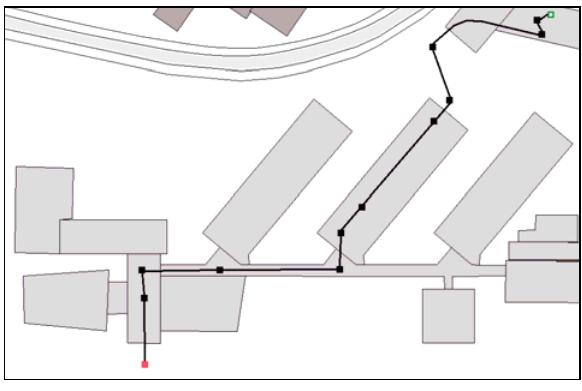
Figure 8. Secretariat path. Ground floor, 1 st floor, Library, 2 nd floor.